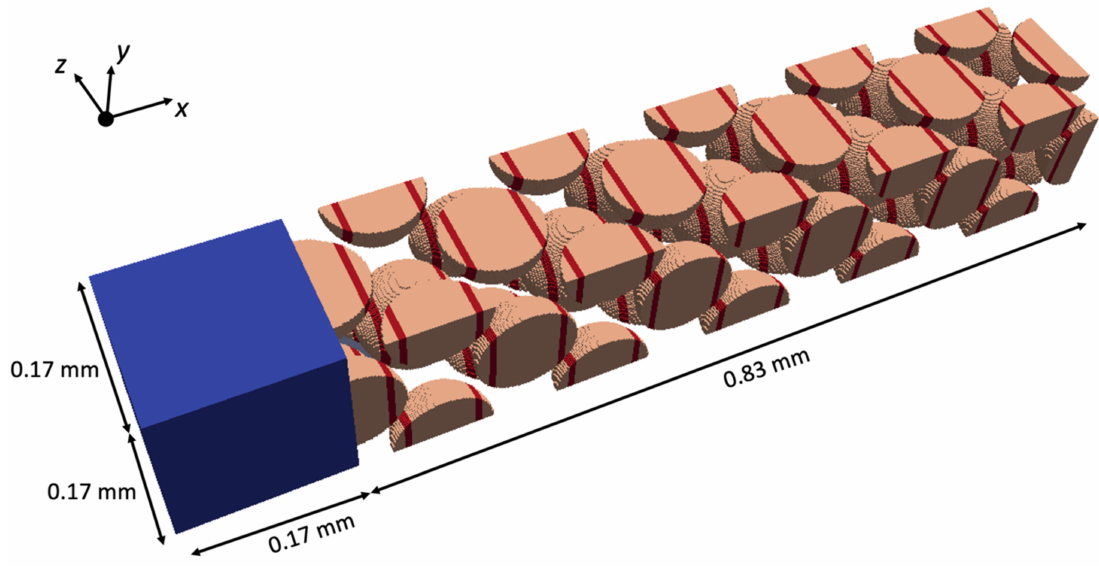
Figure 8. Simplified three-dimensional porous medium, consisting of spherical particles (brown) with reduced wettable coating (red) and water source (blue) at the left